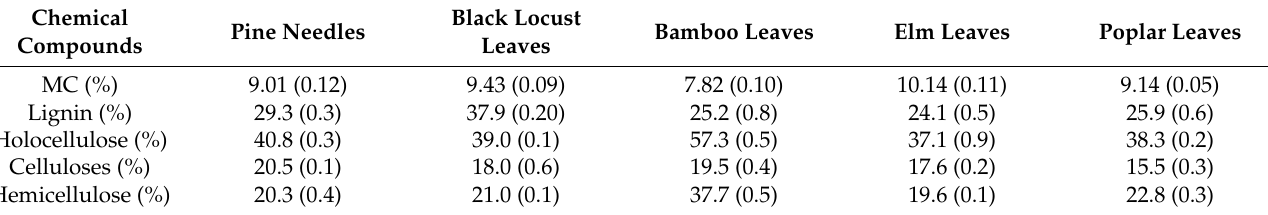
Table 1. Chemical compound contents of different